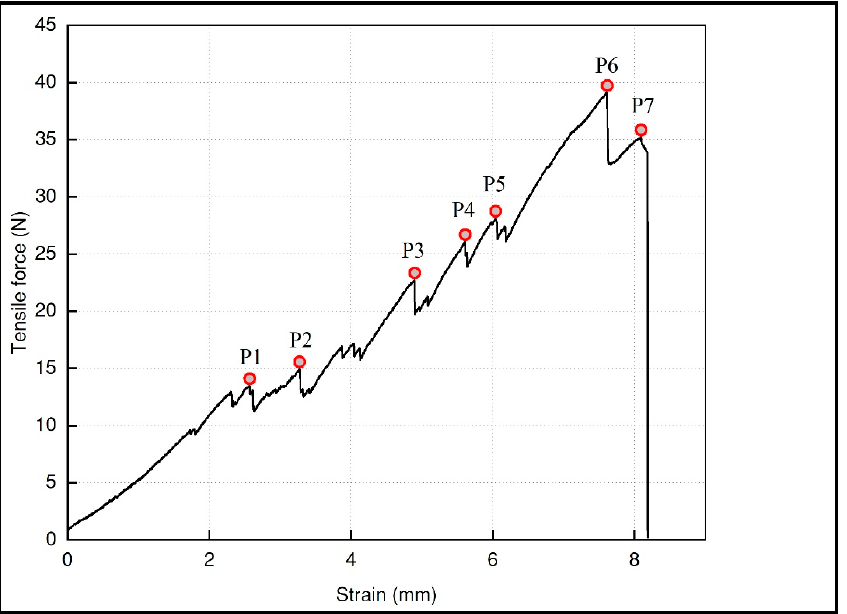
Figure 5 . Fluctuations in the loads recorded in the force − deformation curve of the specimen 2.6.